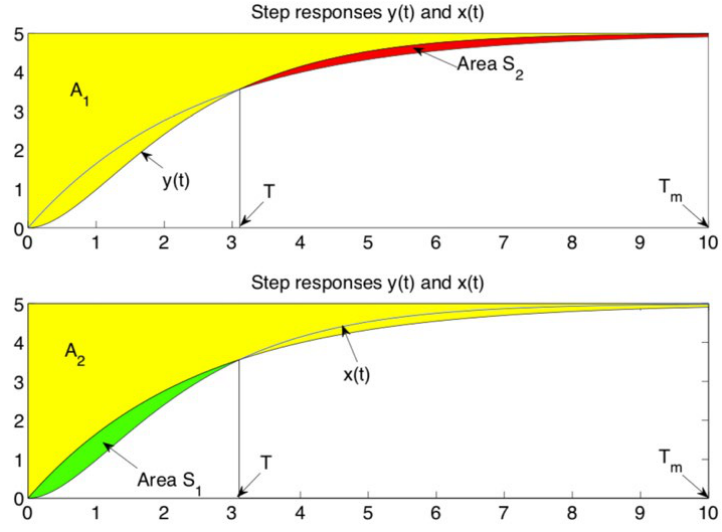
Figure 1. Corresponding areas for the algorithm on an overdamped system response.